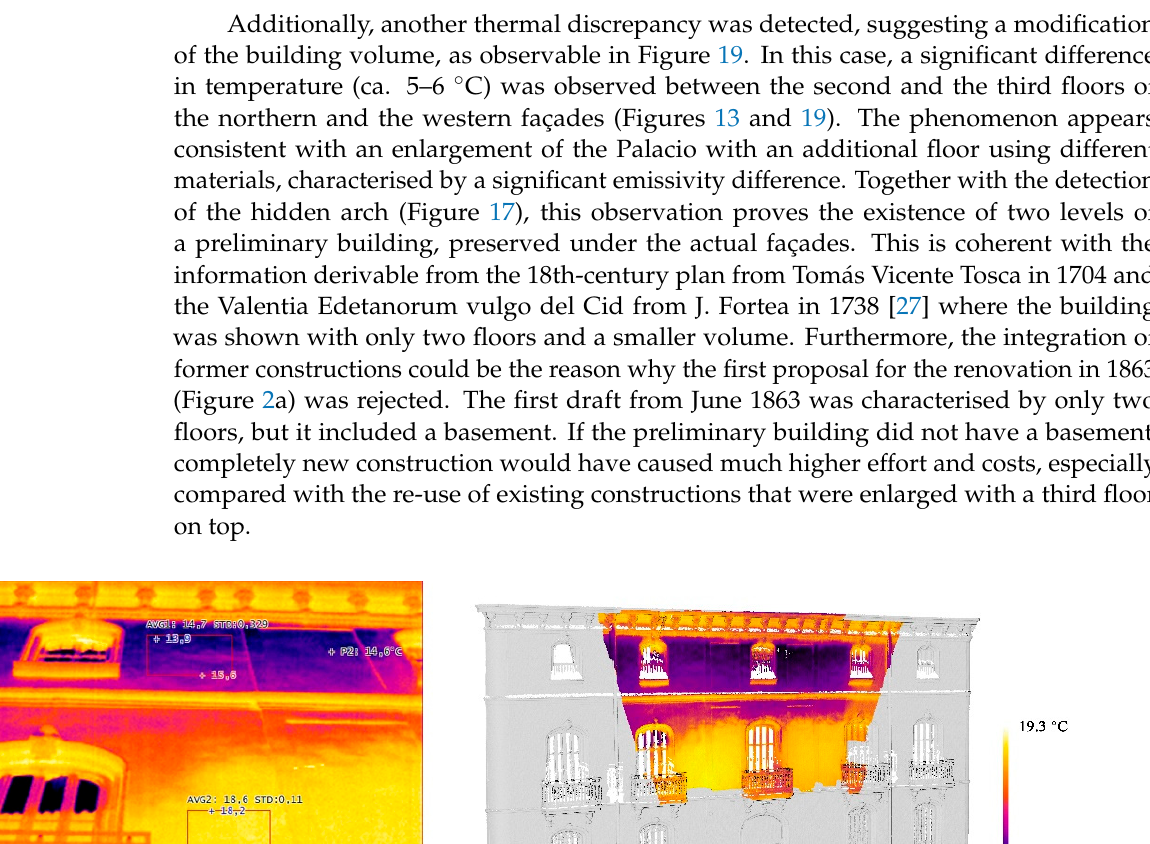
Figure 18. Decorative niches on the façade of the Boil de Arenós Palace, Street of Libreros, Valencia.